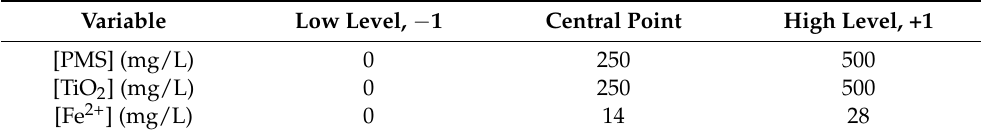
Table 1. Levels of selected